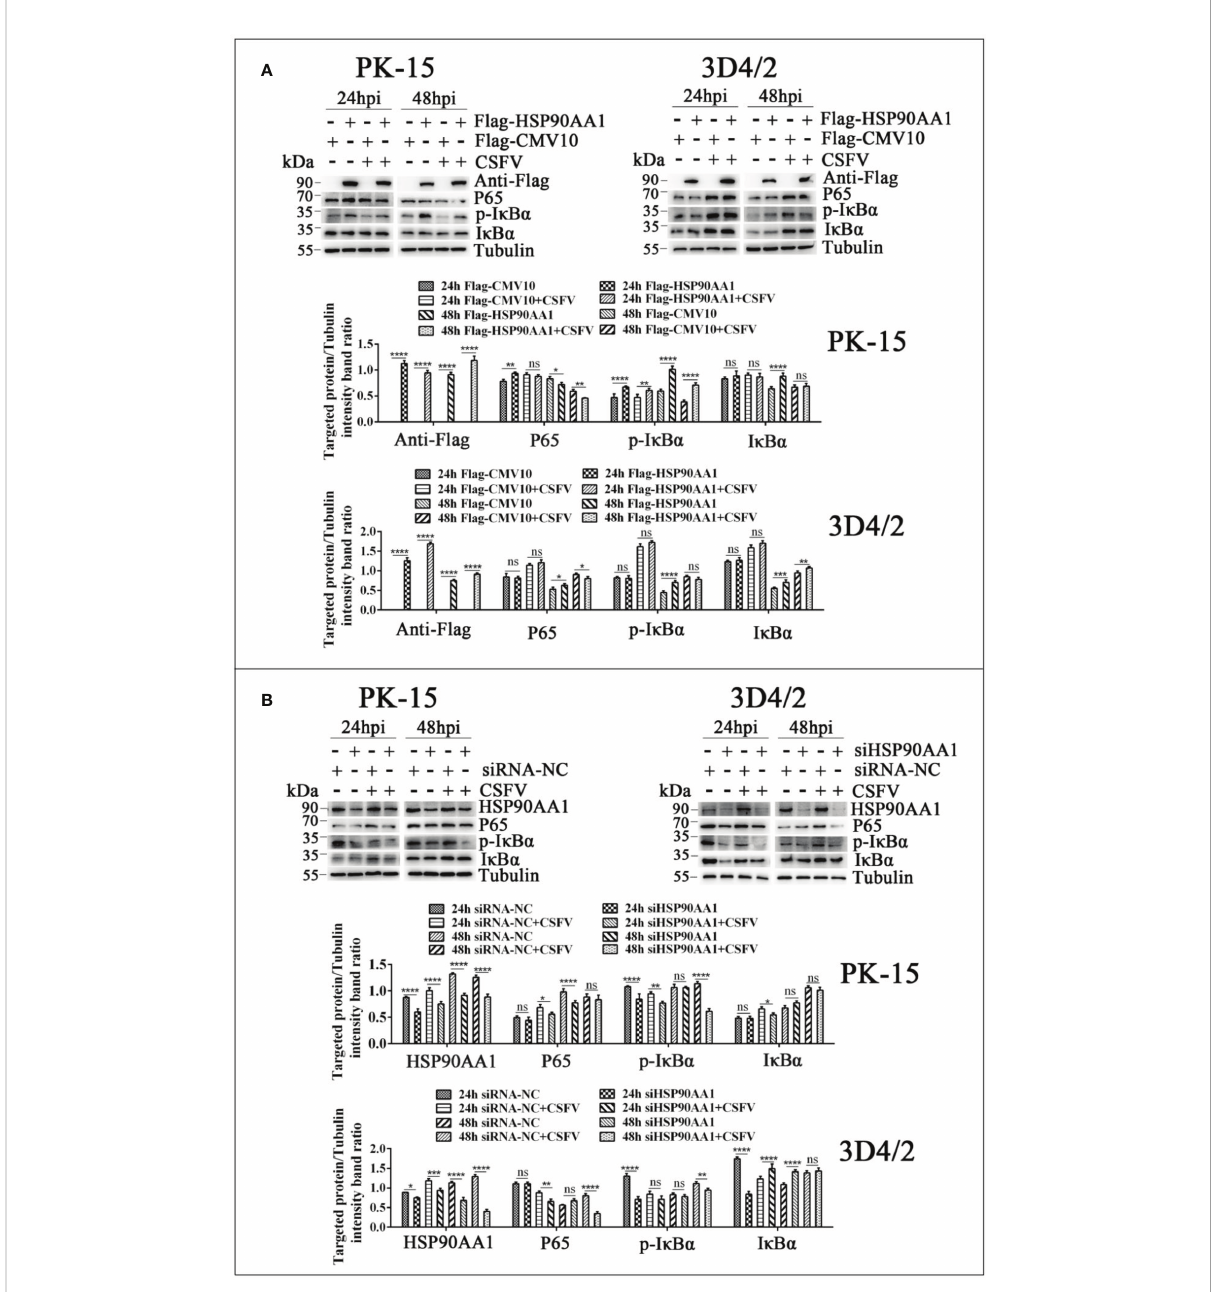
FIGURE 9 CSFV infection antagonizes the activation of HSP90AA1 on NF- k B pathway. (A, B) Western blot for P65, p-I k B a and I k B a in HSP90AA1- overexpression or knock-downed PK-15 and 3D4/2 cells. Cells were infected with CSFV (MOI=1) after transfection p3×Flag-HSP90AA1 or siHSP90AA1, and the cells were not infected with CSFV as a control. Cells were harvested at 24hpi and 48hpi served to Western blot. The relative levels of proteins were estimated by histograms representing density reading of the gel bands with Image J, and the ratios were calculated relative to tubulin control. (*p < 0.05, **p < 0.01, ***p < 0.001 and ****p < 0.0001 calculated using two-way ANOVA, ns, not signi fi